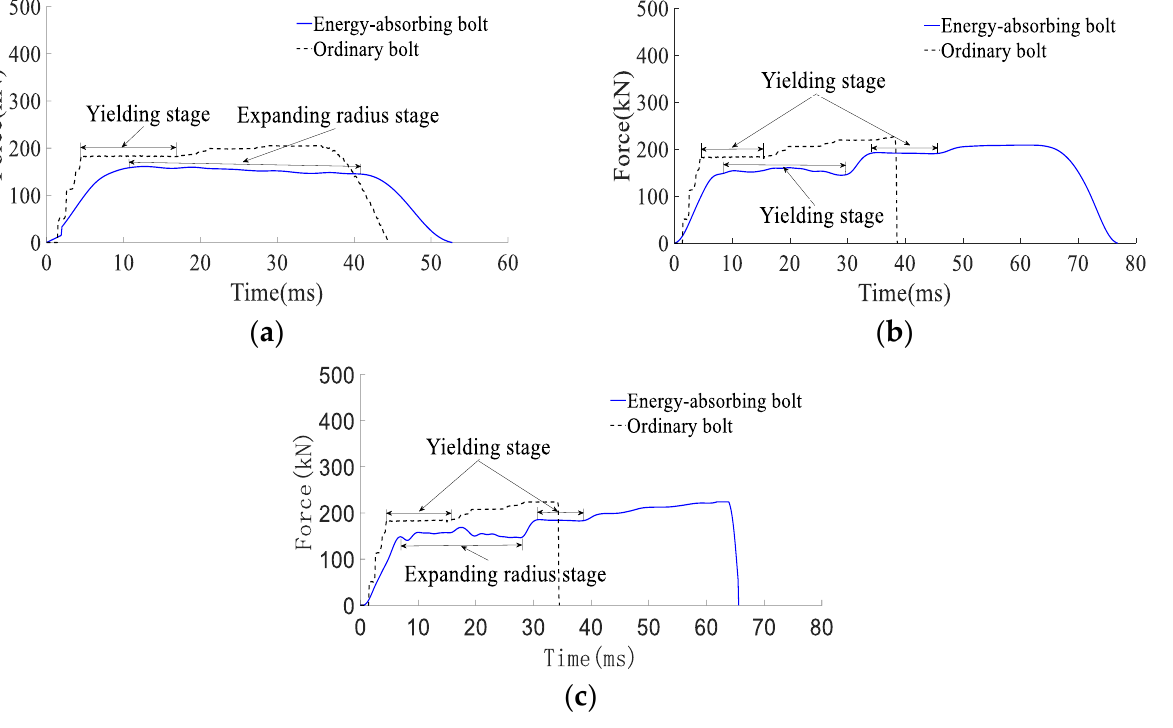
Figure 8. Anchor force – time curve: ( a ) impact energy 25 kJ; ( b ) impact energy 50 kJ; ( c ) impact energy 80 kJ.